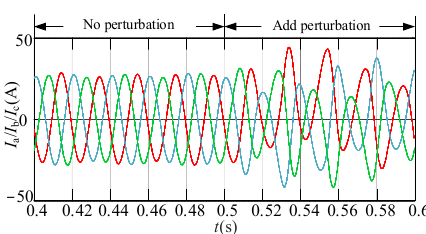
Figure 2. The stator current waveform output by the DFIG.